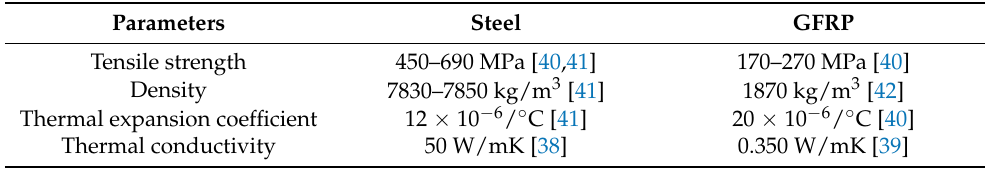
Table 1. Parameters of steel and GFRP for reinforcing bars.